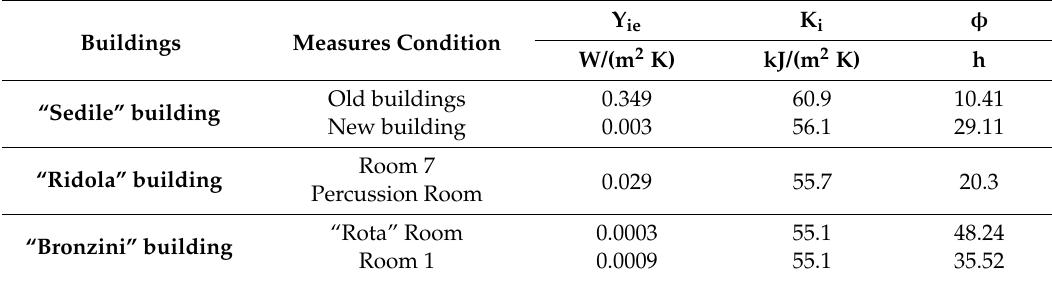
Table 4. Thermal dynamic